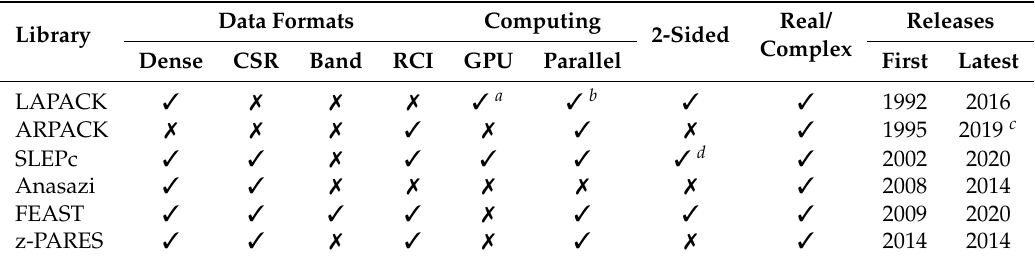
Table 4. Relevant features of open-source libraries for non-symmetric eigenvalue problems. Data Formats Computing Library